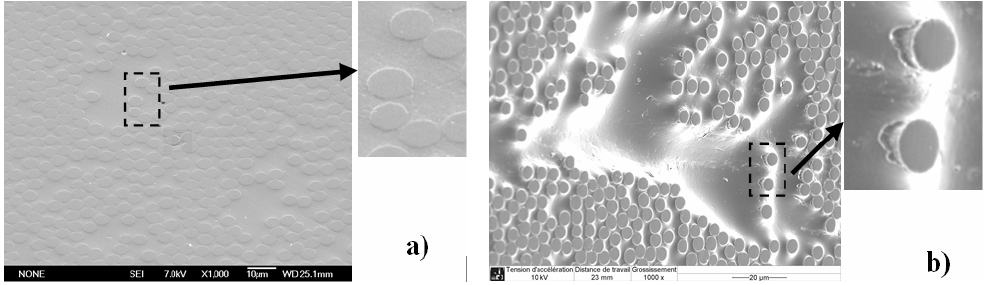
Fig. 5. SEM observations (45° tilted) of samples isothermally aged at 150°C under atmospheric air: a) 192h and b)